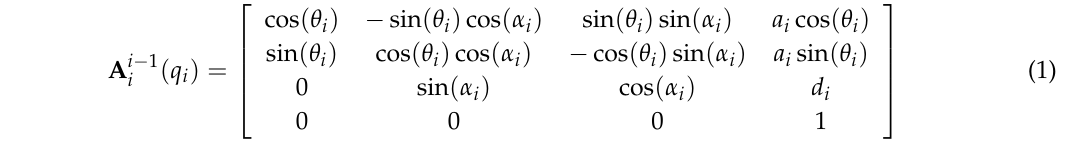
Figure 1. Geometrical configuration of the 6-DoF redundant planar manipulator robot and assignation of the D-H coordinate system (perspective